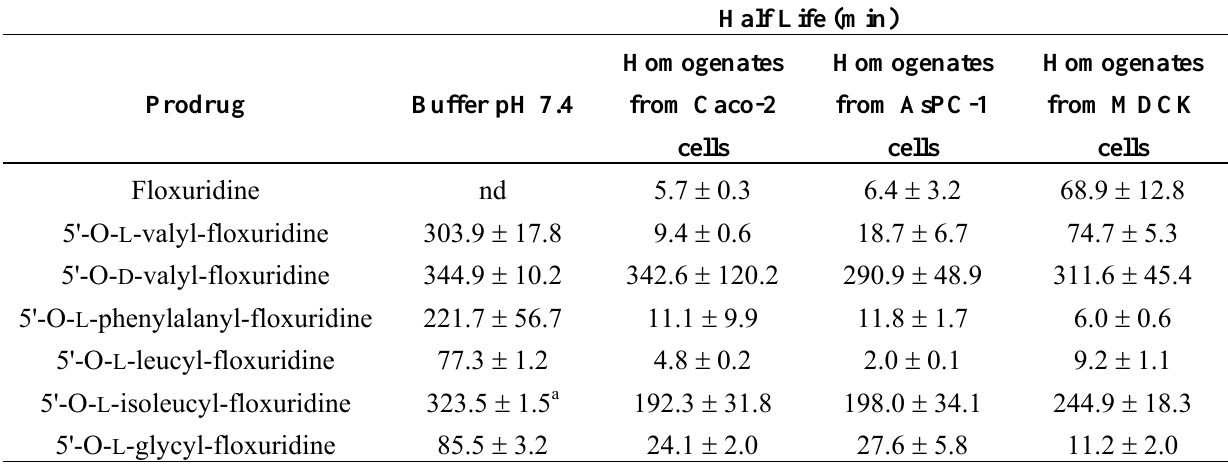
Table 2 . Half-lives of the hydrolytic degradation of floxuridine prodrugs in pH 7.4 buffer, and in homogenates from Caco-2 cells, AsPC-1 cells, and MDCK